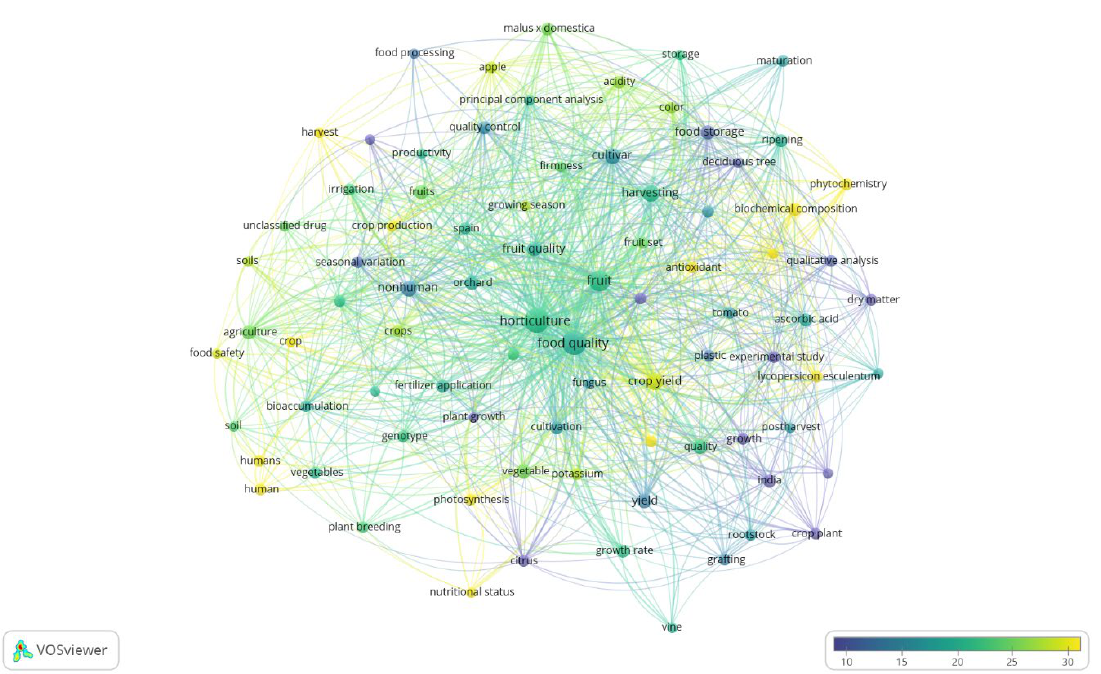
Figure 1. Term map for the relationship of horticulture/horticulturae and food quality research. Bubble size represents the number of publications. Bubble color represents the citations per publication (CPP). Two bubbles are closer to each other if the terms co-appeared more frequently (Bibliometric data were extracted from the Scopus online database and elaborated by the VOSviewer software).